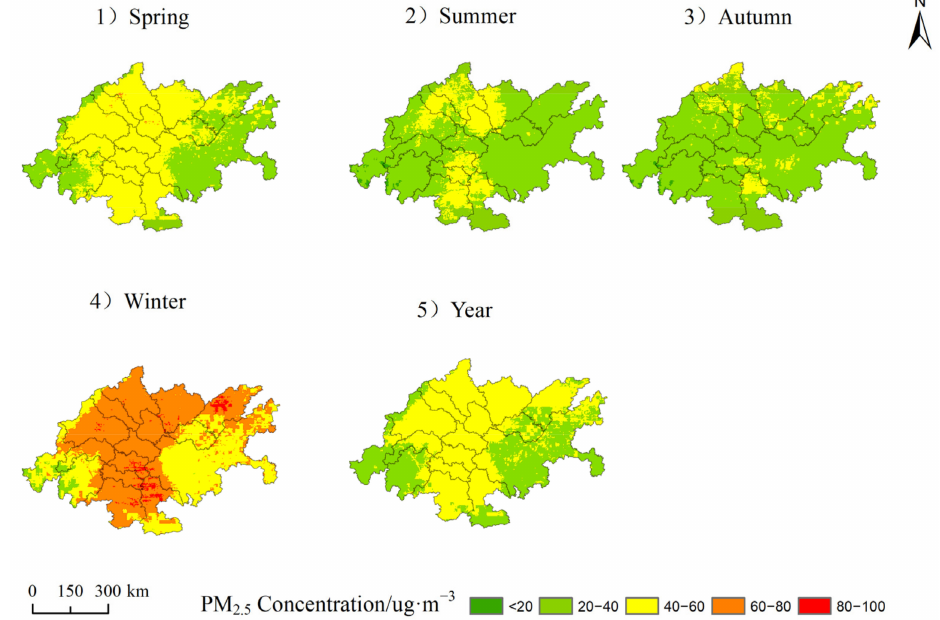
Figure 6. Distribution of PM 2.5 in four seasons and annual average in area in